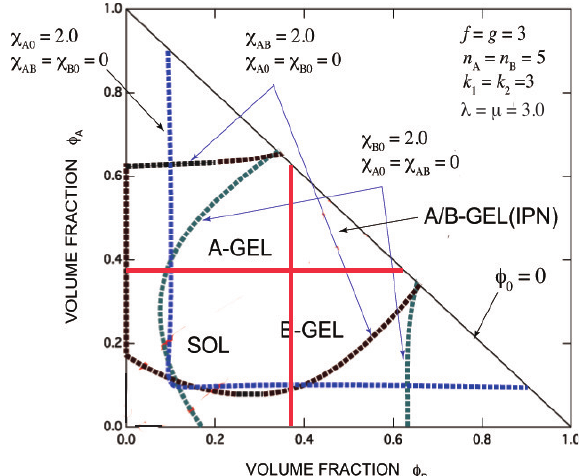
Figure 8. A typical example of phase diagrams for a symmetric IPN shown on the triangular volume fraction plane at a given temperature with fixed multiplicities k 1 = 3, k 2 = 3 for trifunctional A- and B molecules f = g = 3 with λ = µ = 3.0 and γ ( A ) = γ ( B ) = 1. SOL region, A-GEL region, B-GEL region and IPN region (A/B-GEL) are indicated. Spinodal lines for AB interaction (blue broken line), for poor solvent of A (black broken lines) and for poor solvent of B (green broken lines) are also